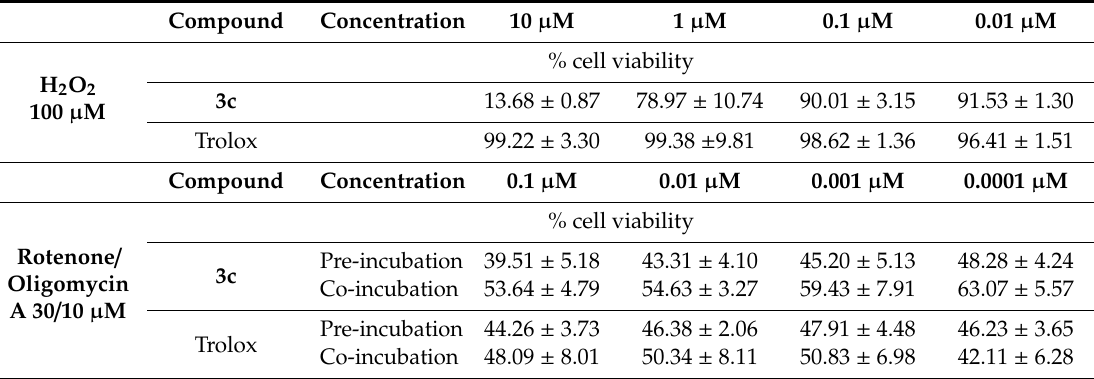
Table 2. SH-SY5Y cell viability (%) after treatment with H 2 O 2 (100 µ M) or a mixture of rotenone (30 µ M) and oligomycin A (10 µ M) at selected concentrations of 3c . Cell viability was determined by the MTT test. Data were expressed as the mean ± SD. Experiments were performed in quadruplicate and repeated three times. Compound Concentration 10 µ